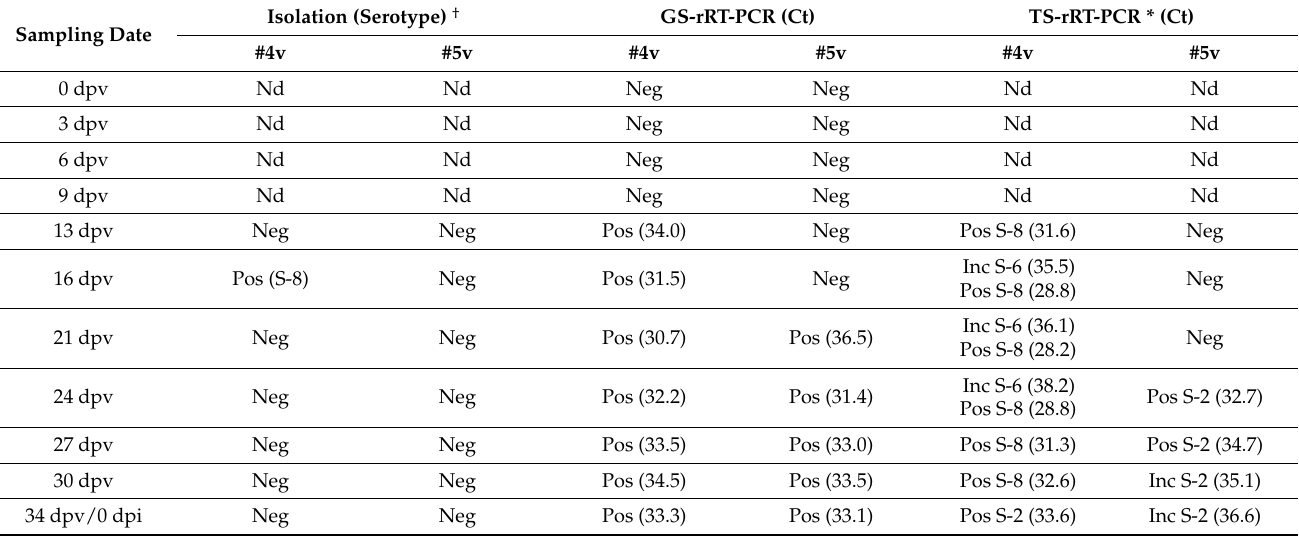
Table 4. Comparative AHSV detection in EDTA blood samples of vaccinated horses (#4v and